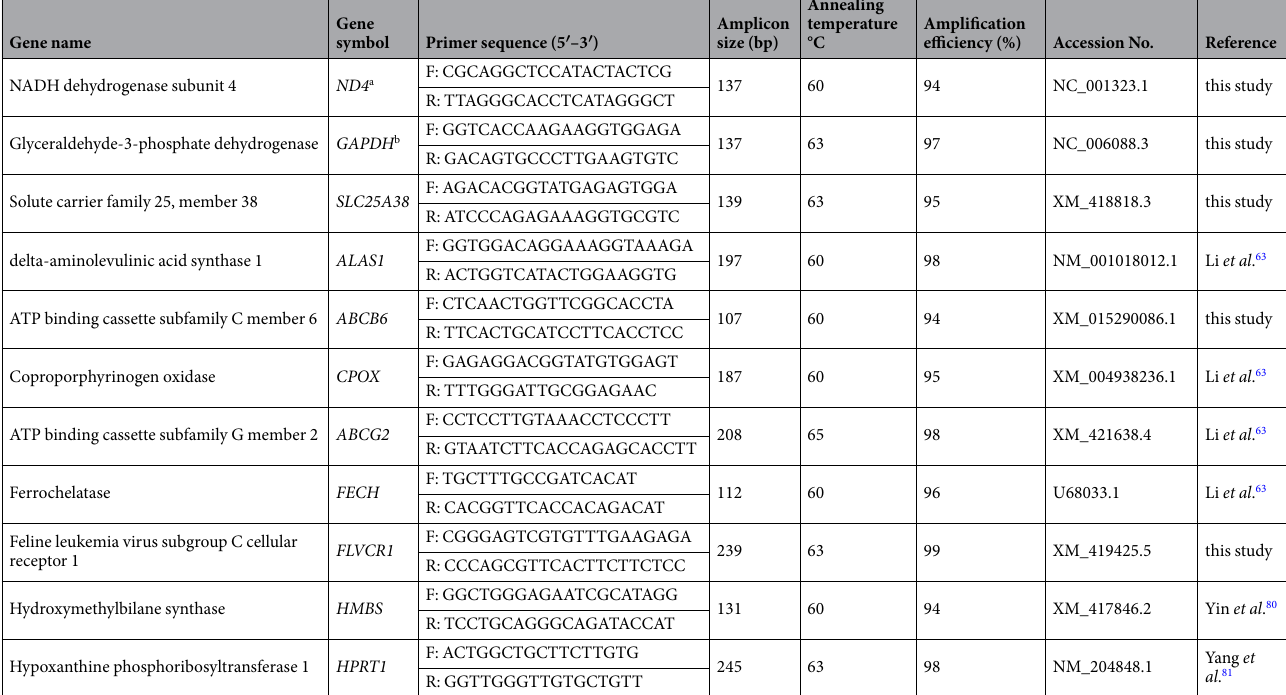
Table 5. Forward (F) and reverse (R) sequences of the primers used in the study. a Gene was used to amplify fragment of mtDNA; b Gene was used to amplify fragment of